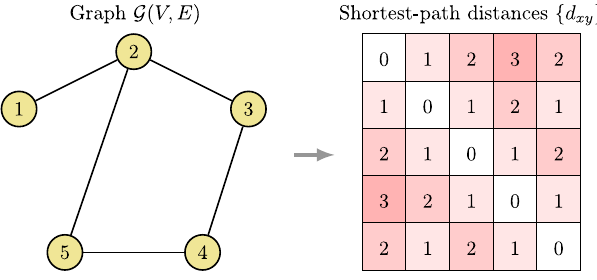
FIG. 3. Example of the Wasserstein distance defined based on a graph consisting of five vertices and five edges. Given the topology G ð V; E Þ , the shortest-path distances f d calculated, from which the Wasserstein distance can be